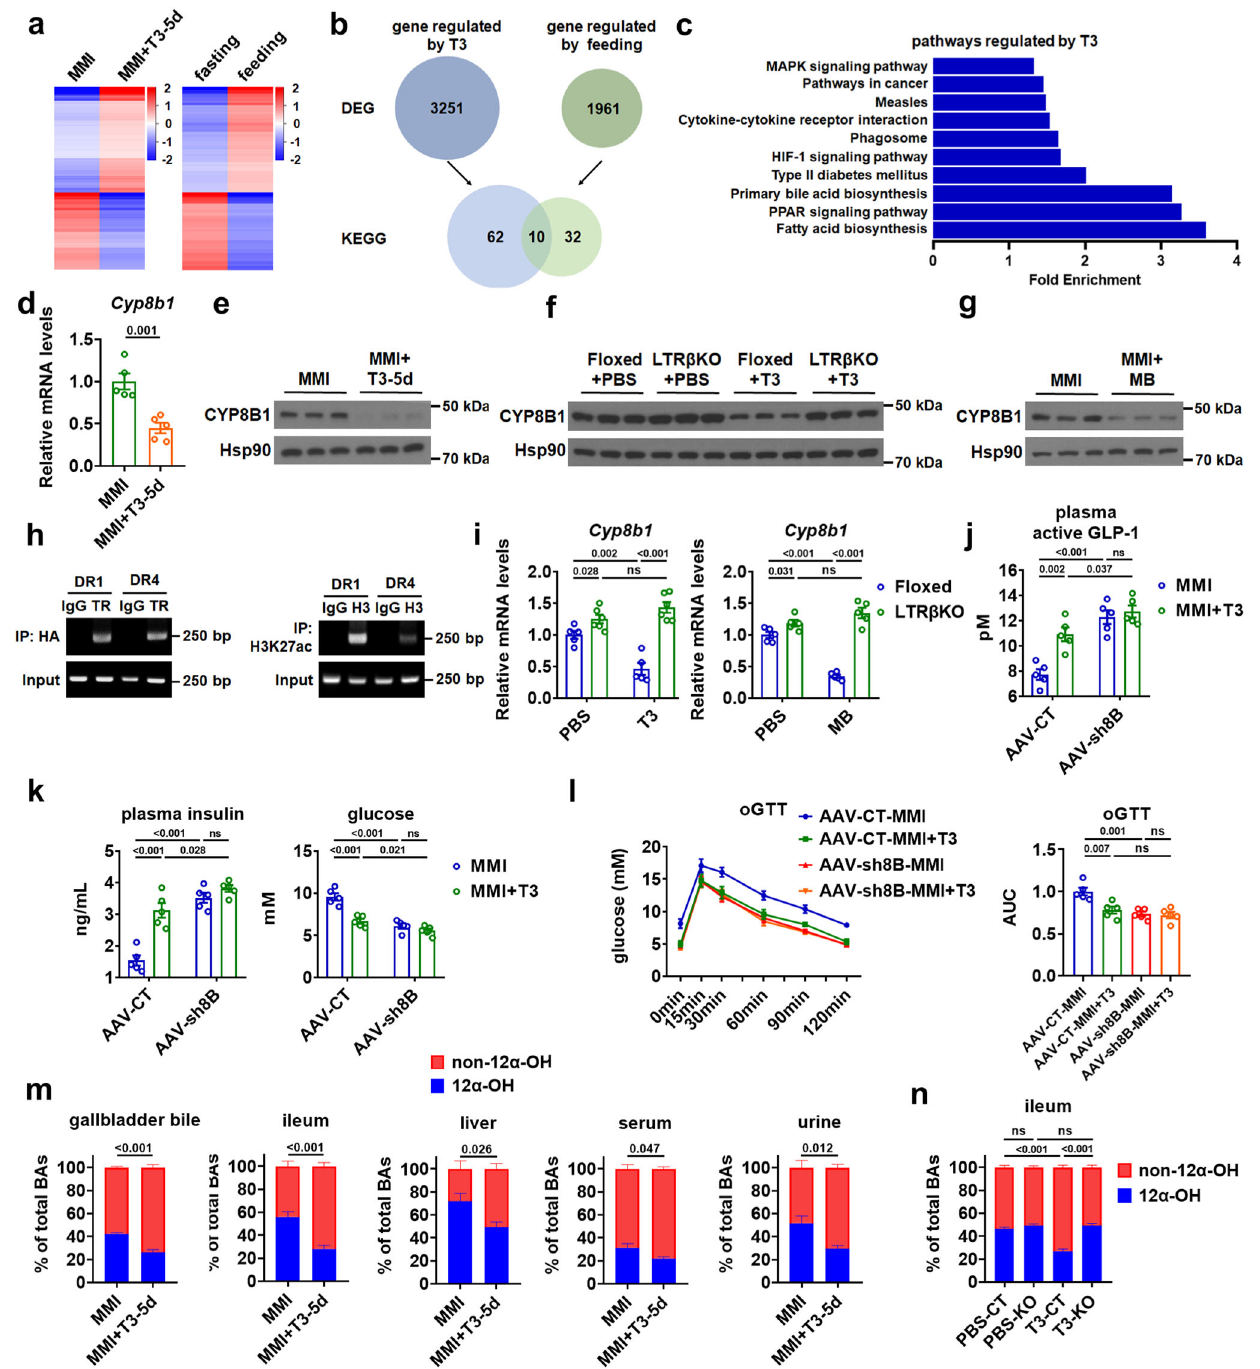
Fig. 4 | TH shapes the BA composition by targeting CYP8B1 in the liver. a Heatmaps of all DEGs identi fi ed by RNA-seq analysis in the liver of MMI mice treated with T3 for 5 days (left, n =3) and microarray analysis in the liver of mice upon feeding (right, n =3). b KEGG analysis of these DEGs in response to T3 treatment and food ingestion, respectively. Venn diagram illustrating commonal- ities and differences in enriched KEGG pathways regulated by T3 and feeding. c KEGG pathways regulated by T3, which are also regulated by feeding, are ranked by fold enrichment. d , e Relative mRNA levels ( d , n =5) and western blot analysis ( e , n =3) of CYP8B1 in the liver of MMI and MMI+T3-5d mice. f Western blot analysis of CYP8B1 in the liver of Floxed and LTR β KO mice treated with PBS or T3 for 5 days ( n =3). g Western blot analysis of CYP8B1 in the liver of MMI mice and MMI mice treated with MB for 5 days ( n =3). h ChIP-PCR analysis of HA-TR β recruitment (left) and H3K27 acetylation (right) in the predicted super-enhancer